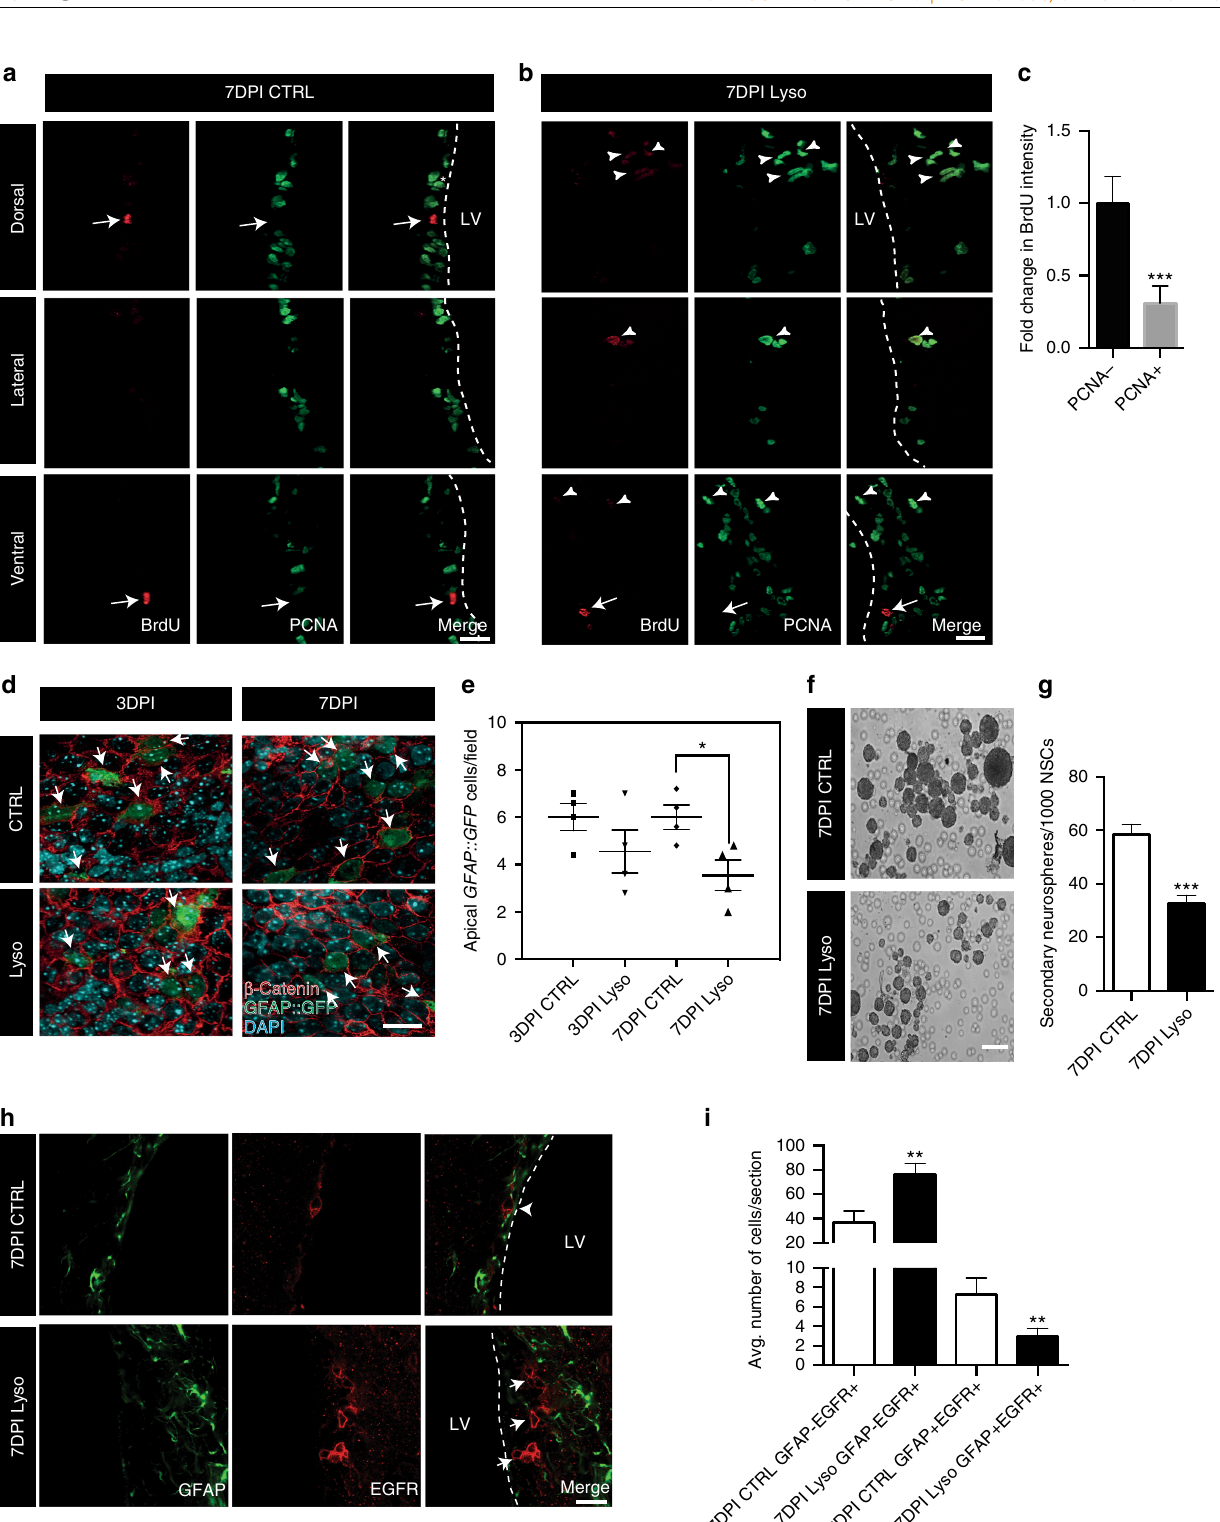
conditions (Supplementary Fig. 7g, h, middle panel). No changes in amplitude and conduction velocity of the UM wave were detected at 7DPI, con fi rming the degree of demyeli- nation was similar in both the LacZ- and NICD-transduced animals (Amplitude: control, 0.23 ± 0.04 mV, n = 19; LacZ: 0.25 ± 0.01 mV, n = 16; NICD: 0.25 ± 0.04 mV, n = 17; p = 0.83, analysis of variance (ANOVA); Conduction velocity: control,